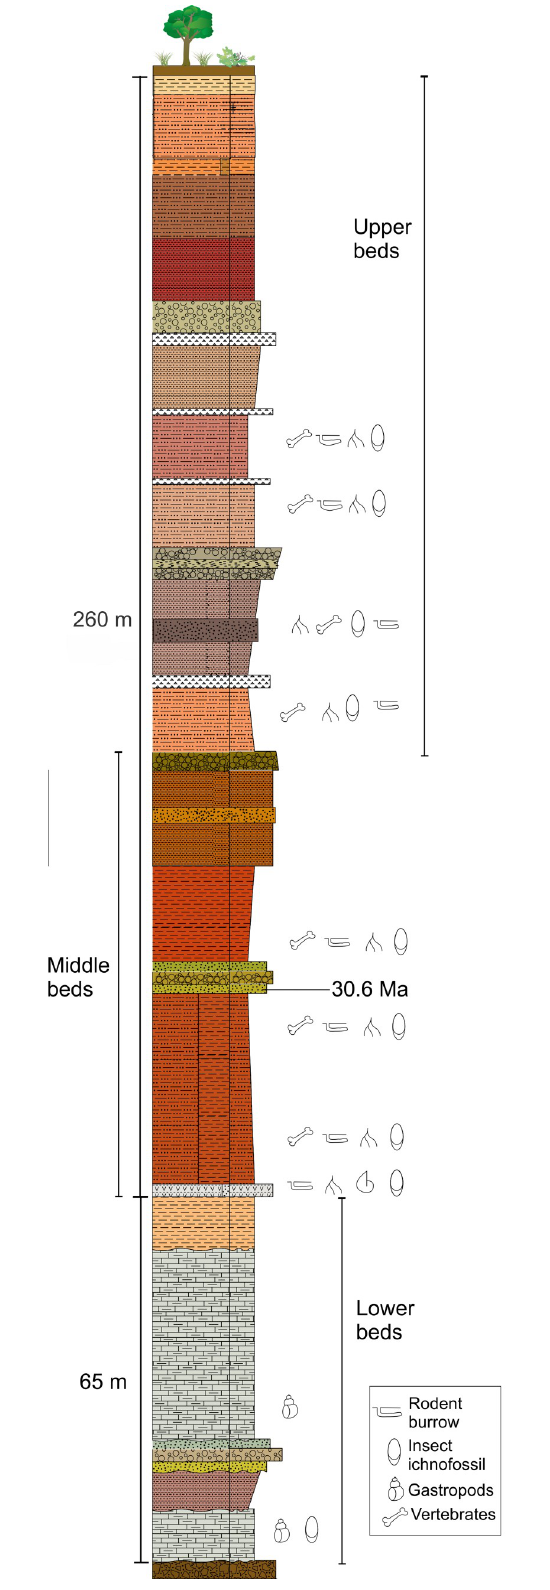
Fig 2. Generalized stratigraphic column of the oligocene sequence of Santiago Yolomecatl, Oaxaca, southern Mexico. https://doi.org/10.1371/journal.pone.0230040.g002 PLOS ONE | https://doi.org/10.1371/journal.pone.0230040 March 12,